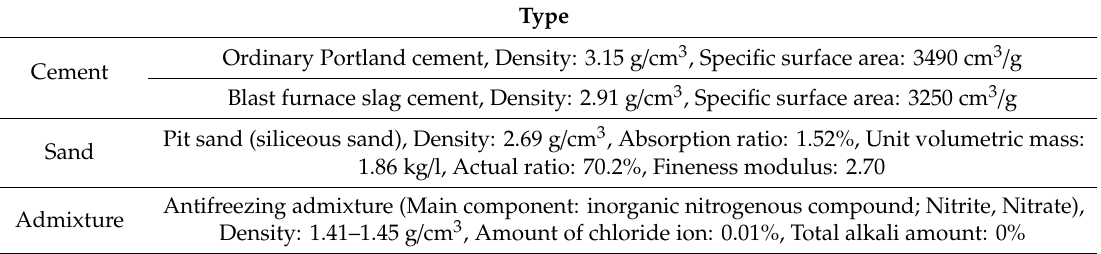
Table 2. Materials Used.